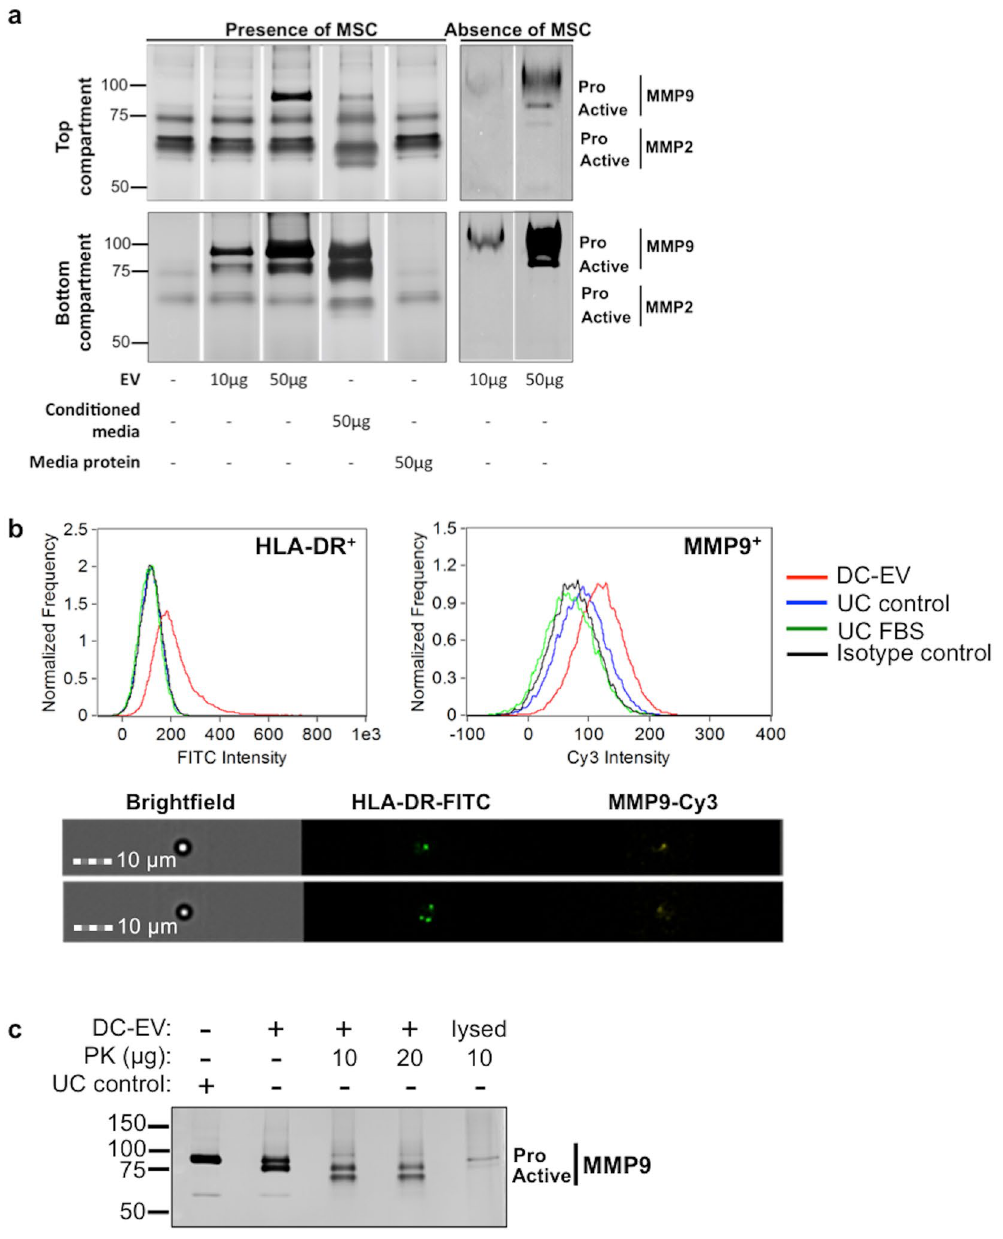
Figure 6. DC-derived EV contain MMP-9 capable of promoting MSC migration. ( a ) Detection of MMP-9 and MMP-2 activity by gelatin zymography in media collected from transwell assays. Cell culture media from top and bottom compartments of MSC recruitment transwell assays was collected separately. Protein was precipitated from these media (Presence of MSC) and from DC-EV pellets (Absence of MSC), resolved by gelatin zymography, and proteolytic activity was detected as clear bands on Coomassie Brilliant Blue stained gels. Bands corresponding to the proenzyme and the active form of each MMP are indicated at the corresponding molecular weight next to gels images. ( b ) Representative imaging flow cytometry plots (top panel) and images (bottom panel) of MMP-9 and HLA-DR detection in DC-derived EV coupled to beads. Beads with EV were stained with HLA-DR-FITC antibodies before being permeabilized and stained using anti- MMP-9 followed by Cy3-secondary antibodies, being detected as defined dots in the periphery of the beads. ( c ) Gelatin zymography detection of MMP-9 in DC-derived EV (DC-EV), and the 100 K ultracentrifugation supernatant control (UC control). Proteinase K (PK) digestion, with or without previous vesicle lysis, were performed as indicated. Pro-MMP-9 and active MMP-9 are indicated at the corresponding molecular weight. Full gel scans are available in Supplementary Fig.